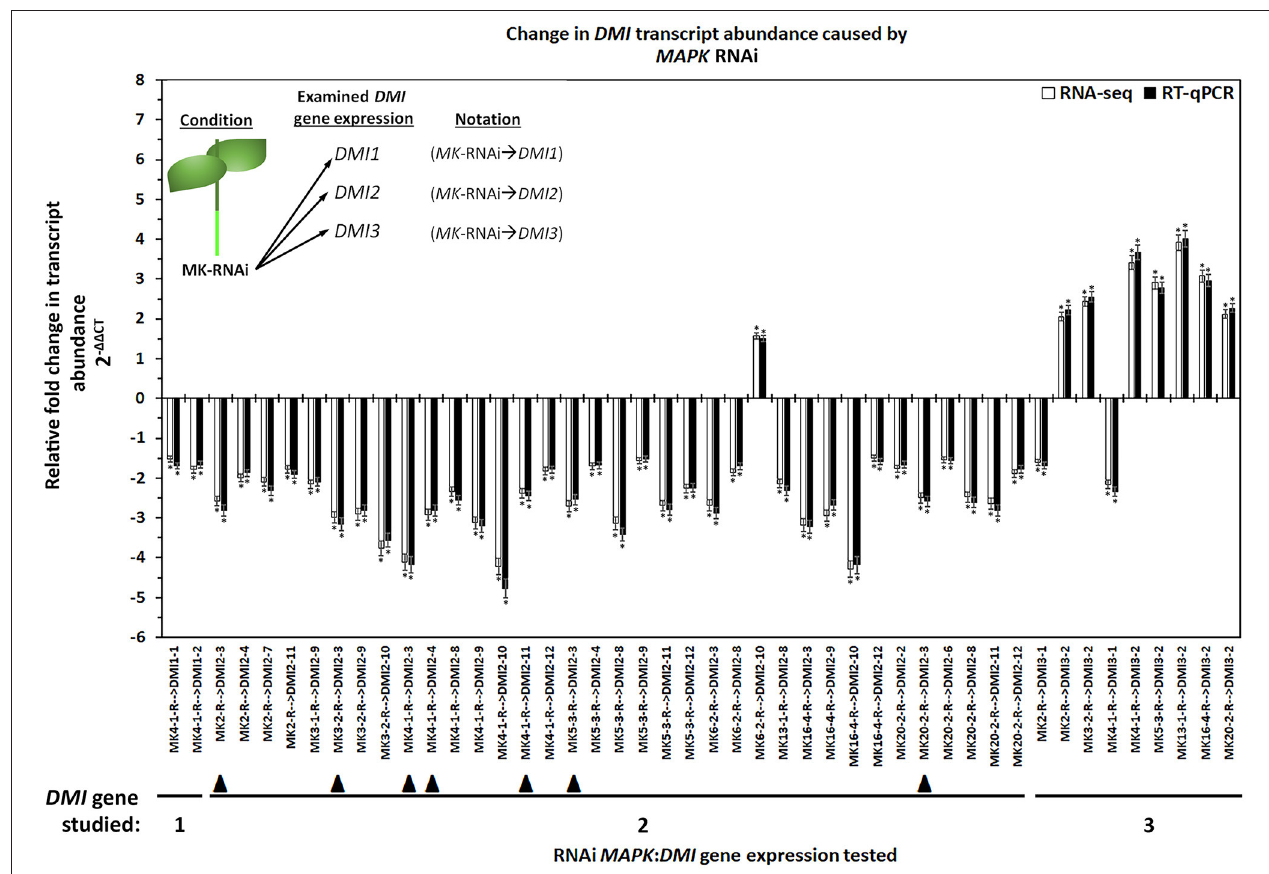
FIGURE 4 | The results for the DMI1 , DMI2 , and DMI3 gene family members that had exhibited differential expression in the defense MAPK -RNAi roots measured by RNA-seq and confirmed by RT-qPCR ( Livak and Schmittgen, 2001; Wang and Wang, 2021). The data presented in (Figure) analyzes the MAPK -RNAi root RNA by RNA-seq and RT-qPCR. The sample analysis type presented below the x-axis provides the analysis parameter as MAPK -RNAi with the presented gene expression for the specific DMI gene denoted by an arrow ( → ) giving MAPK ( specific gene )-RNAi → DMI ( specific gene ). (*) The RNA-seq result is statistically significant at p < 0.001, Student’s t -test. RT-qPCR expression was calculated by 2 − 11 C T to enumerate the RTA as presented as the FC (Livak and Schmittgen, 2001; Klink et al., 2021a). (*) RT-qPCR result statistically significant at p < 0.05, Student’s t -test (Yuan et al., 2006). The DMI genes that had contrasting expression (an FC that was increased [I] in the MAPK -OE RNA-seq and RT-qPCR analyses ( Figure 3 ), and an FC that was decreased [D] in MAPK -RNAi RNA-seq, and RT-qPCR analyses (Figure 4), referred to as an MAPK -OE:RNAi couplet as designated in the Results subsection: Cross-comparative analyses involving MAPK -OE and MAPK -RNAi experiments) were indicated with a black triangle ( N ). An arrow ( → ) denotes the DMI gene whose expression was examined in relation to the MAPK -OE:RNAi RNA-seq and RT-qPCR analyses. This designation was made for MAPK2 -OE:RNAi → DMI2-3 (I:D), MAPK3-2 -OE:RNAi → DMI2-3 (I:D), MAPK4-1 -OE:RNAi → DMI2-3 (I:D), MAPK4-1 -OE:RNAi → DMI2-4 (I:D), MAPK4-1 -OE:RNAi → DMI2-11 (I:D), MAPK5-3 -OE:RNAi → DMI2-3 (I:D) and MAPK20-2 -OE:RNAi → DMI2-3 (I:D). This figure presents data for 46 couplets. Details have been provided in Supplementary Table 7 . Please refer to Materials and Methods subsections: RNA-seq gene